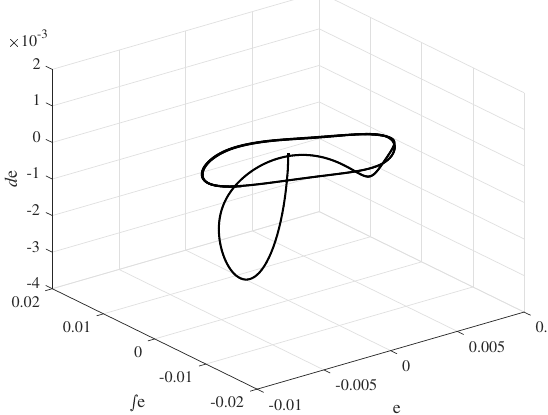
(cid:82) e -˙ e under periodic speed tracking.